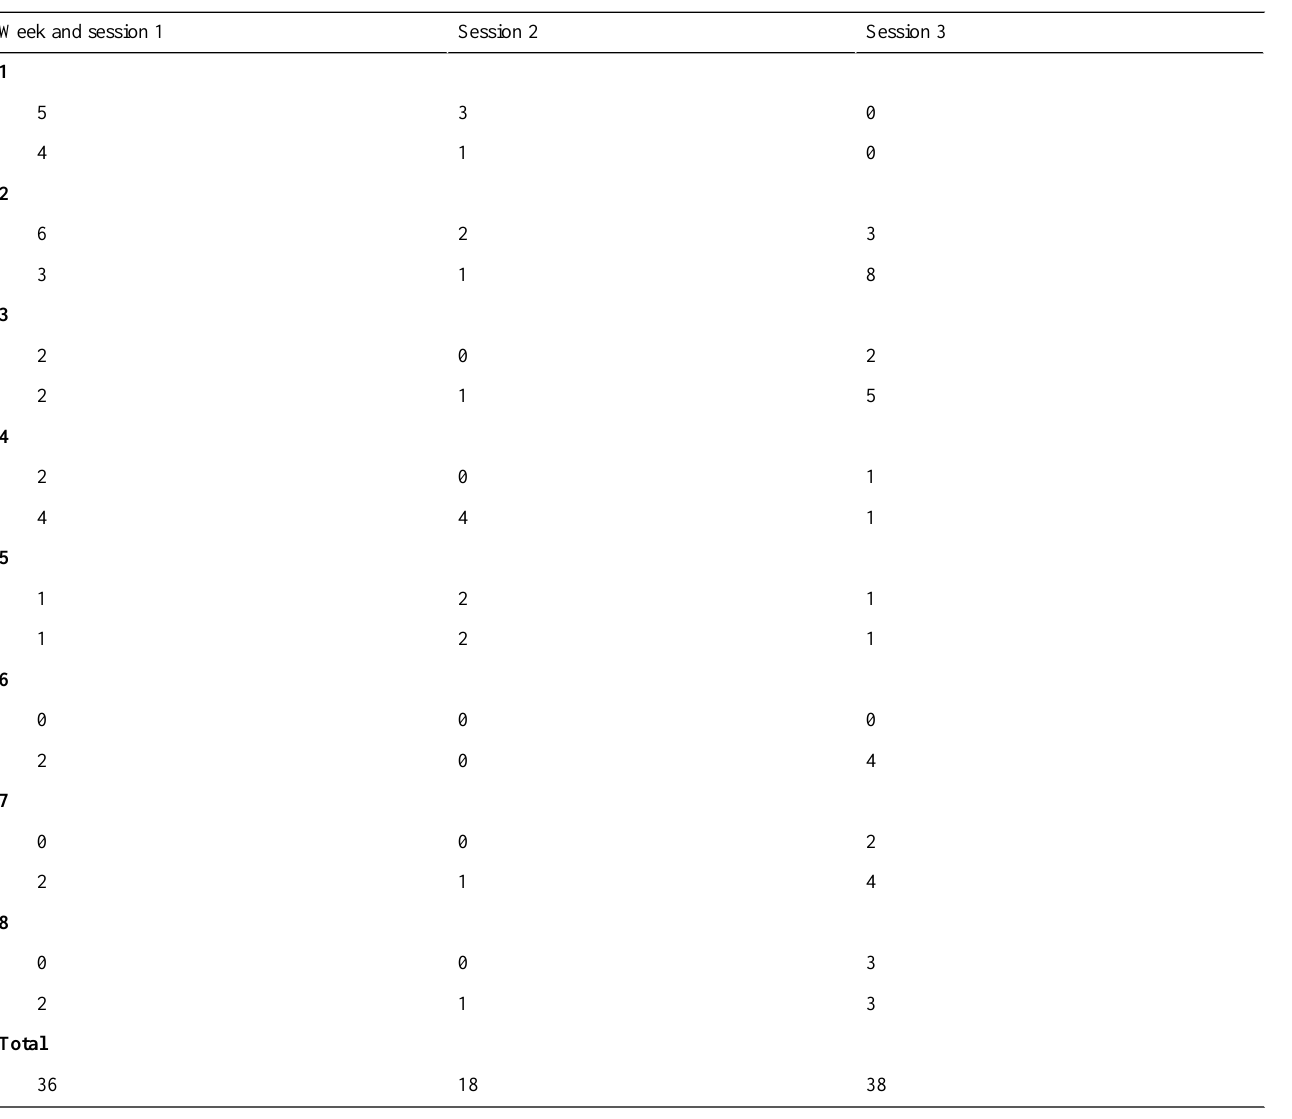
Table 5. Videoconferencing session